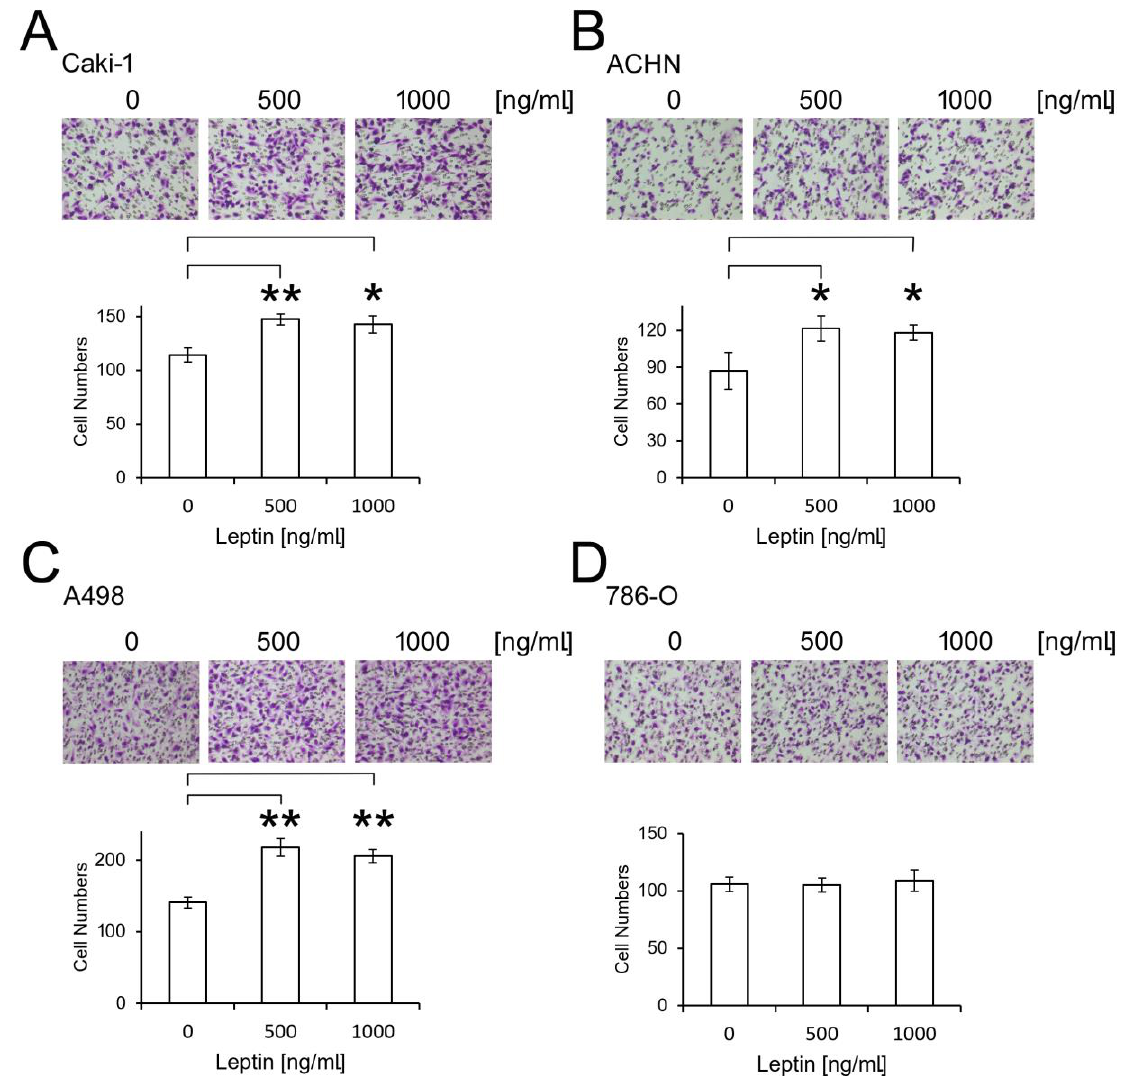
Figure 3. Investigation of ccRCC cell migration upon leptin treatment. Leptin (500 and 1000 ng/mL) was added to the ccRCC cell lines Caki-1 ( A ), ACHN ( B ), A498 ( C ), and 786-O ( D ) for 24 h. Cancer cell migration ability was then evaluated by transwell assays. The experiments were performed three times and a representative result is shown. The p values at the following levels were considered significant: * p < 0.05, ** p < 0.01.